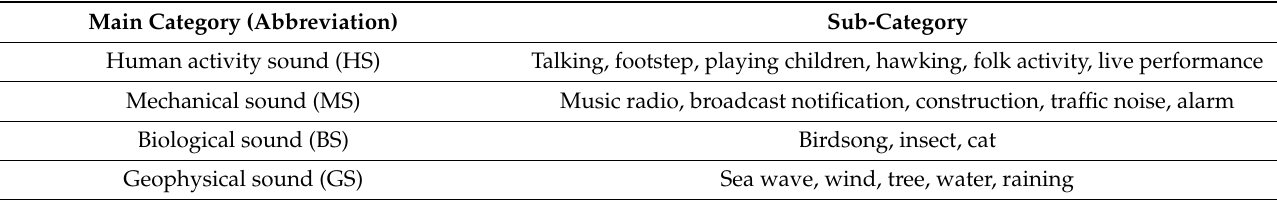
Table 1. Classification of sound sources in the study area.